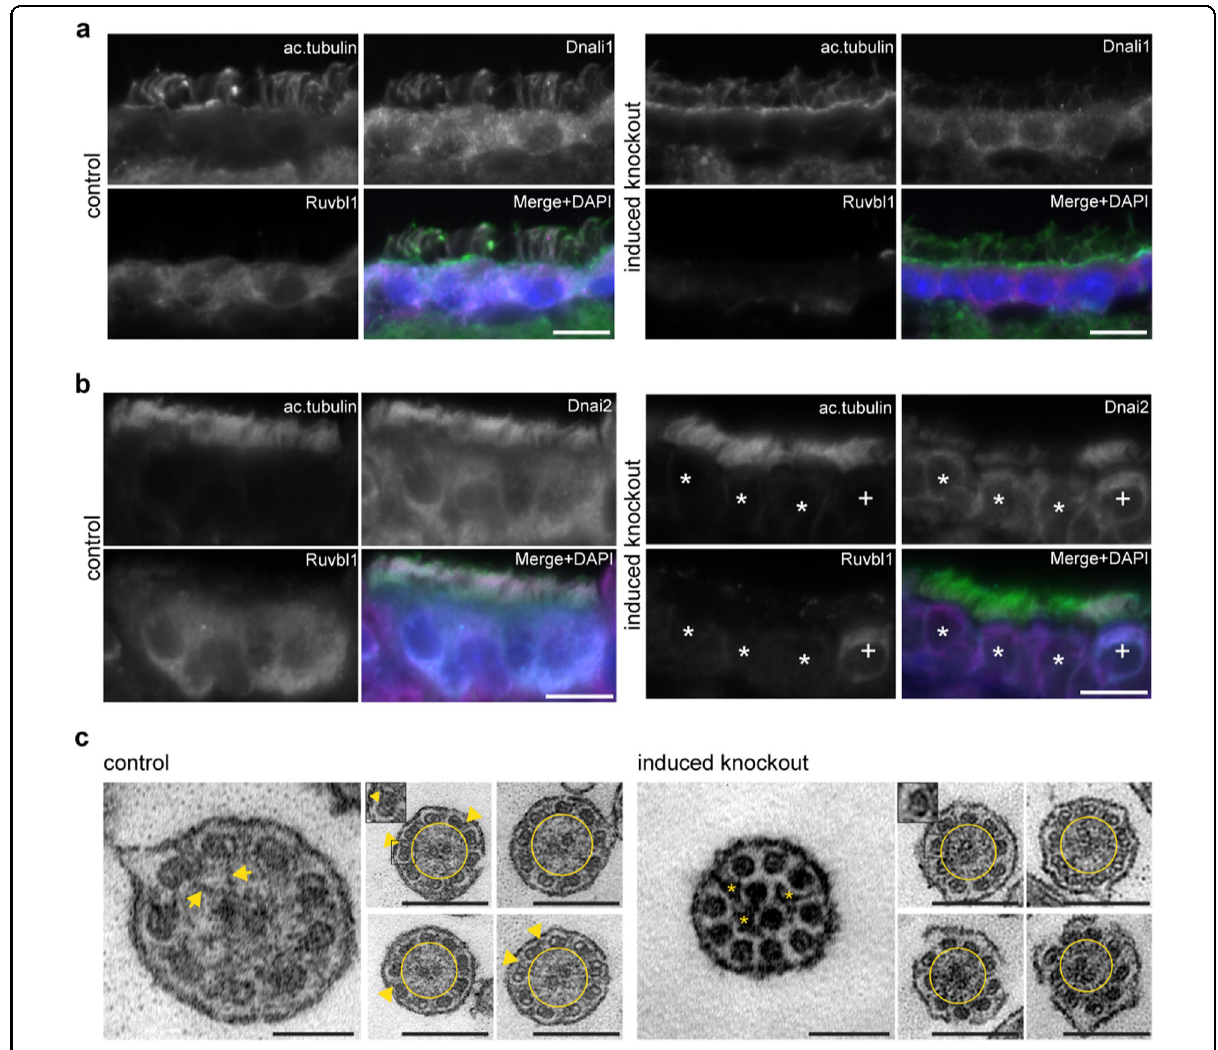
Fig. 6 Ruvbl1 deletion in multiciliated cells results in mislocalization of central dynein components. a Immuno fl uorescence staining of ependymal cells revealed that expression of the inner dynein arm complex member Dnali1 and its ciliary localization was substantially reduced in induced Ruvbl1 knockout mice. Scale bars: 10 µm. b Immuno fl uorescence staining of the ovary duct clearly demonstrated that Dnai2, a compartment of the outer dynein arm complex, lost ciliary localization in multiciliated cells, showing a complete Ruvbl1 knockout (*). Cells still expressing Ruvbl1 showed Dnai2 localization to cilia ( + ). Scale bars: 10 µm. c Transmission electron microscopy of motile cilia in the ovary duct revealed structural ciliary changes after induction of Ruvbl1 knockout. Electron-dense material corresponding to, e.g., radial spokes (marked with arrows) and outer dynein arms (marked with arrowheads) in control mice only. However, in induced Ruvbl1 k nockout mice, these components could not be found. Instead, unde fi ned protein clusters were identi fi ed in motile cilia of knockout mice (asterisks). In addition, in control mice, the nine microtubule doublets were arranged around the central pair in a nearly perfect ring shape, whereas in knockout animals the microtubule doublets were less organized (yellow circle). Scale bars: 100 nm (left) and 250 nm